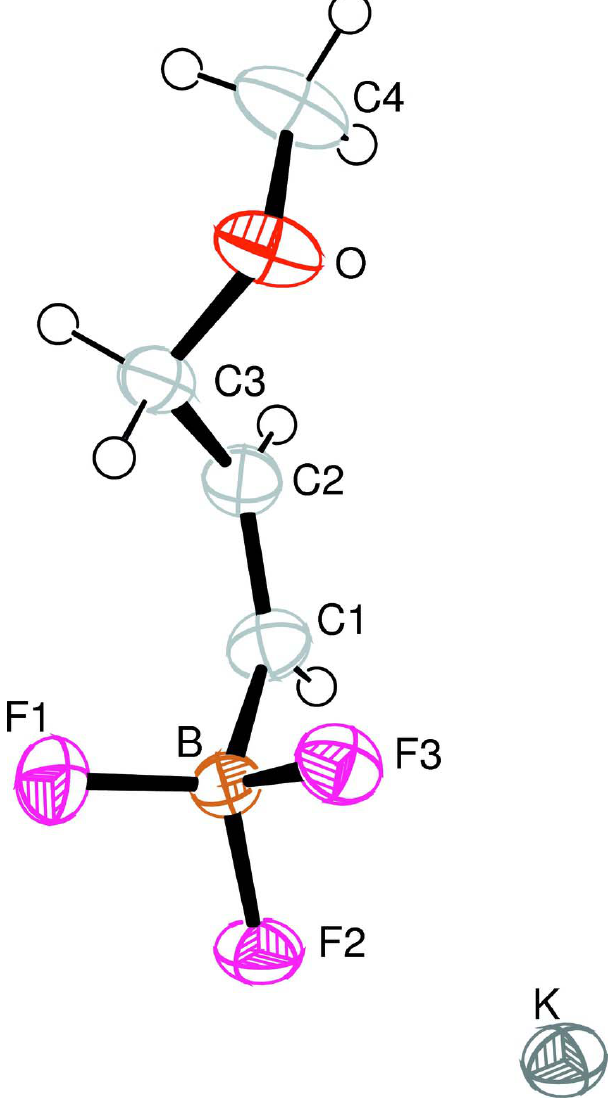
Figure 1 The molecular structure of the title compound showing atom labelling scheme and displacement ellipsoids at the 50% probability level (arbitrary spheres for the H